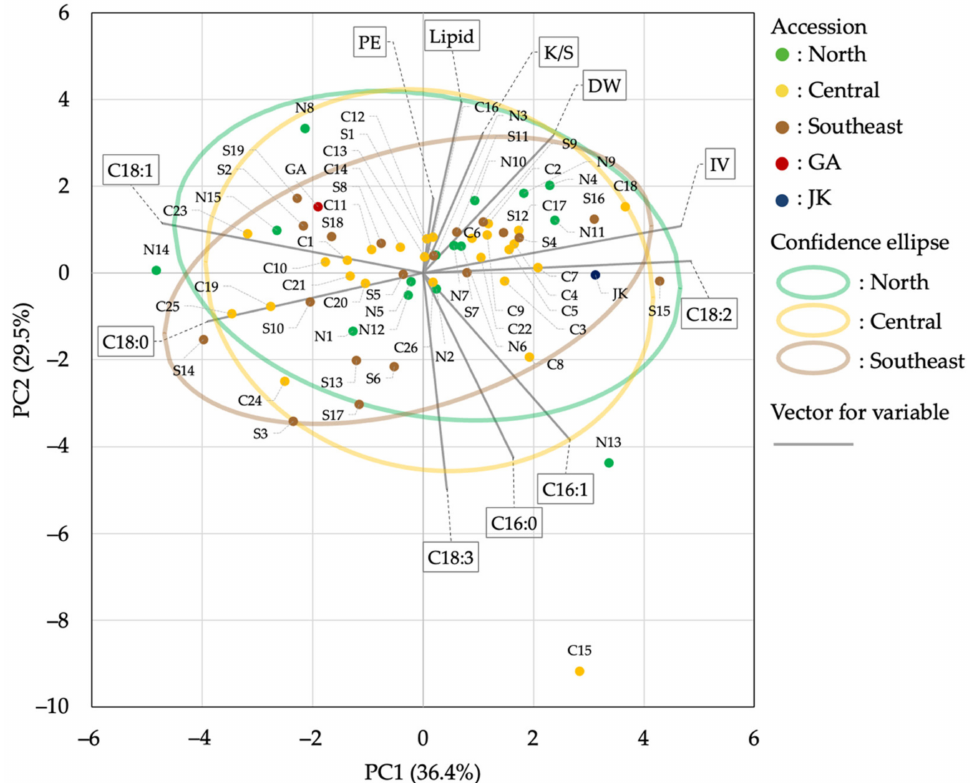
Figure 7. PCA biplot illustrating the chemical trait diversity of Botswanan Jatropha accessions. Accessions from the North (N), Central (C), and Southeast (S) geographical groups are shown as green, yellow, and brown dots, respectively. The error ellipses of the same color show the probability range ( p > 0.9) of the multivariate normal distribution for each geographical group. Vectors in gray indicate the direction and strength of the variable